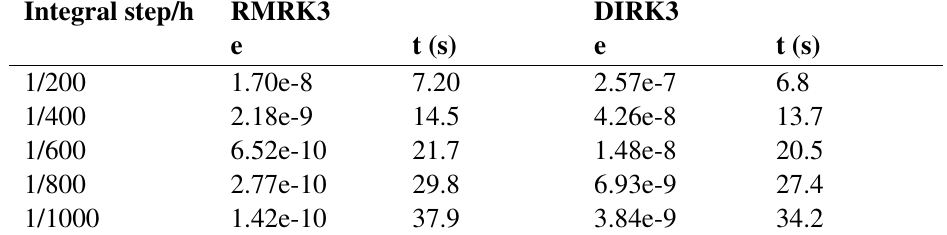
Table 1 Integral step size h, corresponding maximum overall error e and calculation time